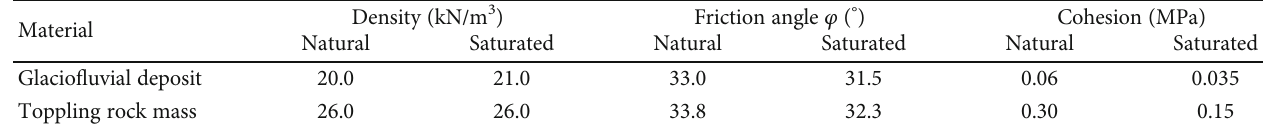
Table 2: Physical and mechanical parameters for glacio fl uvial deposit and toppling rock